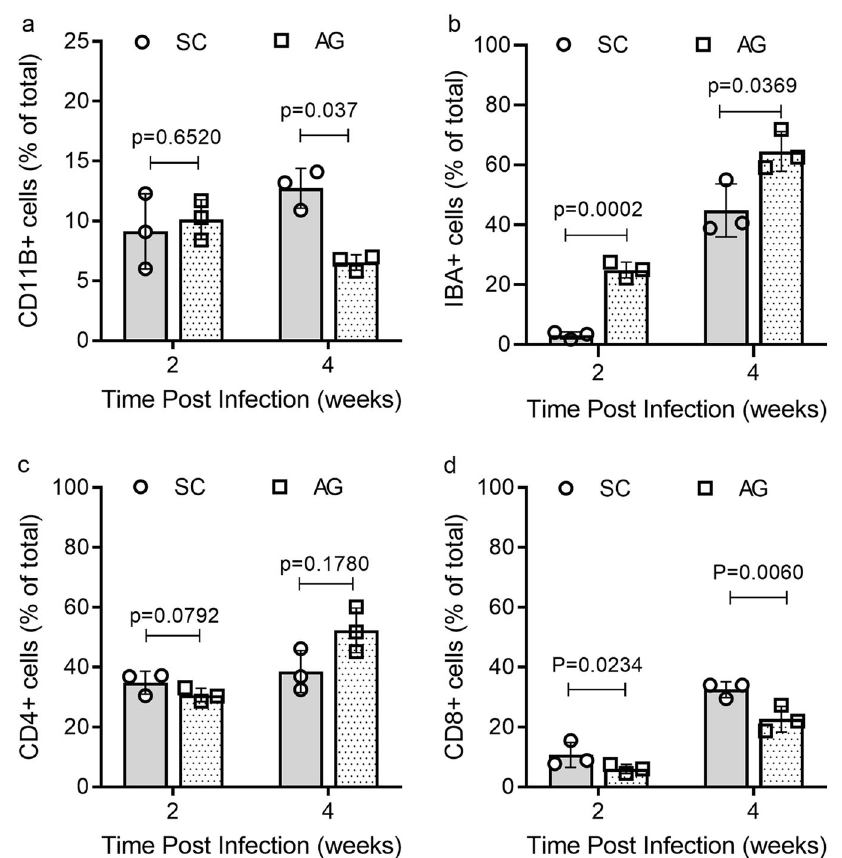
Fig. 4 Immune cell distribution in the lungs after Mtb-AG or SC infection. Lung cells ( a , c ) or tissue sections ( b , d ) from Mtb-SC or Mtb-AG infected rabbits at 2 and 4 weeks were stained with speci fi c antibodies against. a CD11b, b IBA1 (macrophages), c CD4, and d CD8. Stained lung cells were analyzed by fl ow cytometry and stained lung sections were analyzed microscopically, and cells positive for the markers were counted manually in 40 random fi elds from each animal. n = 3 rabbits per group. Data were analyzed by Mann – Whitney U (i.e., 24 h post infection) in fl ammatory response markers in the lungs during Mtb-AG or Mtb-SC infection using quantitative real-time PCR analysis (qPCR). As shown in Fig. 5, infection with Mtb-AG signi fi cantly upregulated the expression of in fl ammatory molecules, such as S100A8 , S100A9 , S100A12 , CRP , HIF1A , MMP1 , MMP9 , TBX21 , and activated NK cell marker, KLRG , surface receptors, PPARG , CD14 , as well as Th-2 type markers, IL4 and ARG1 (Fig. 5). In contrast, expression of antimicrobial molecules, including perforin (PRF1), cationic antimicrobial peptide (CAP18), and in fl ammasome (NLRP13), were upregu- lated in Mtb-SC-infected lungs at 24 h post infection (Fig. 5). The directionality of expression of several of these genes is consistent between the RNAseq and the qPCR data. These observations suggest that Mtb-AG induces a more robust host in fl ammatory